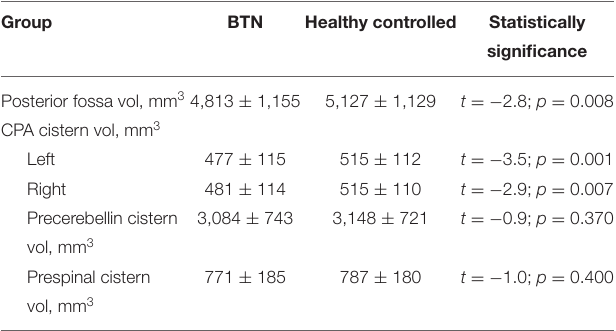
TABLE 3 | Comparison of the volumes of the posterior cranial fossa and cerebellopontine cisterns between the BTN and healthy control groups. Group BTN Healthy controlled Statistically